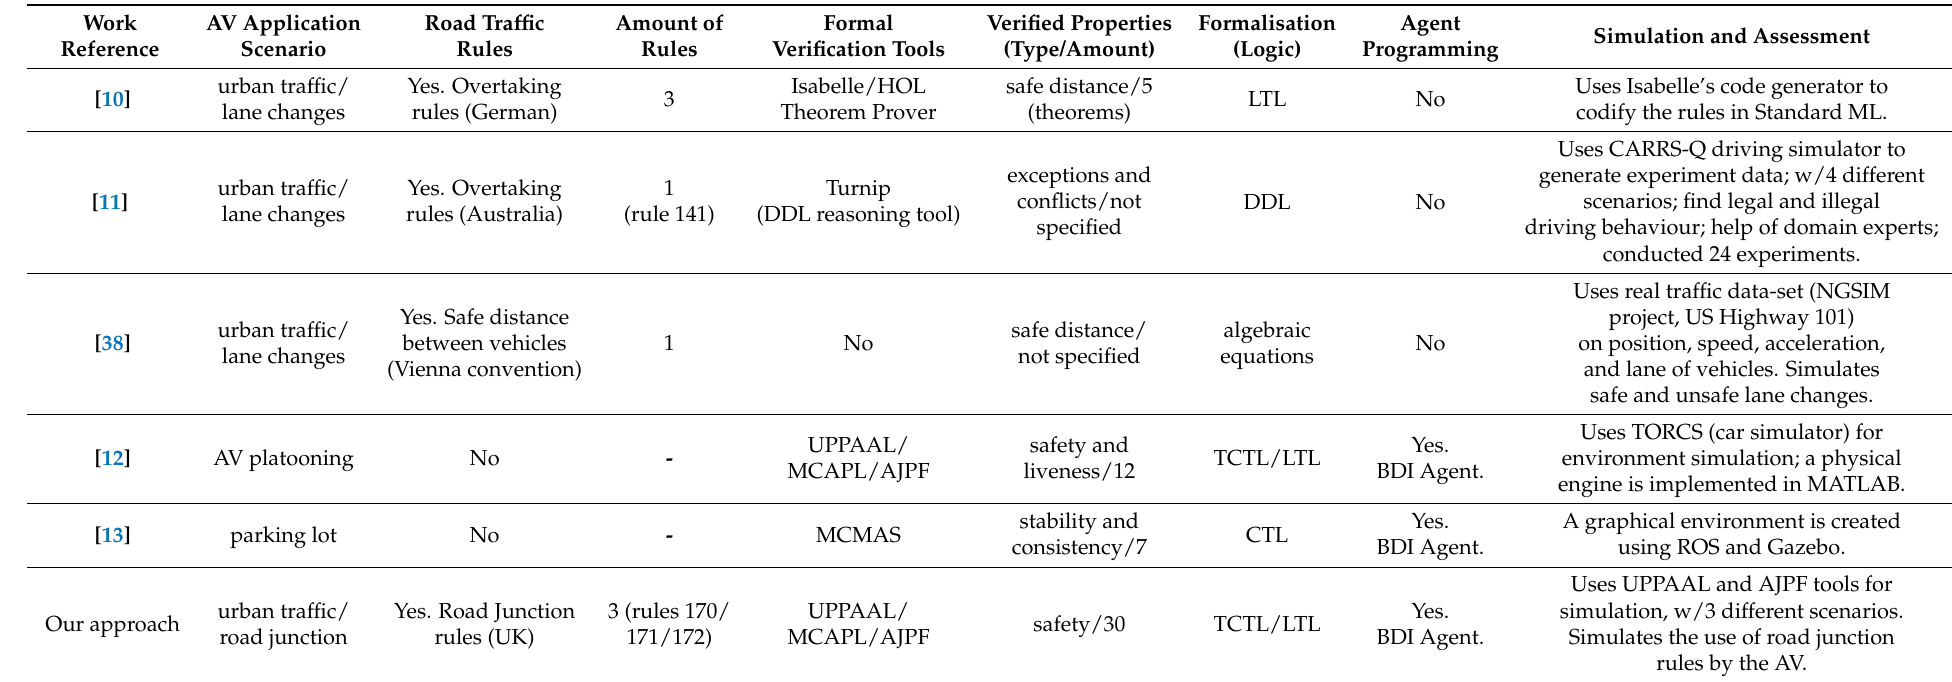
Table 7. Related work